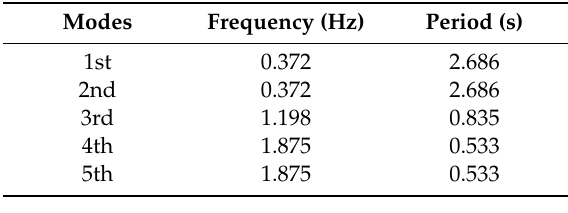
Table 9. Natural frequencies and periods.